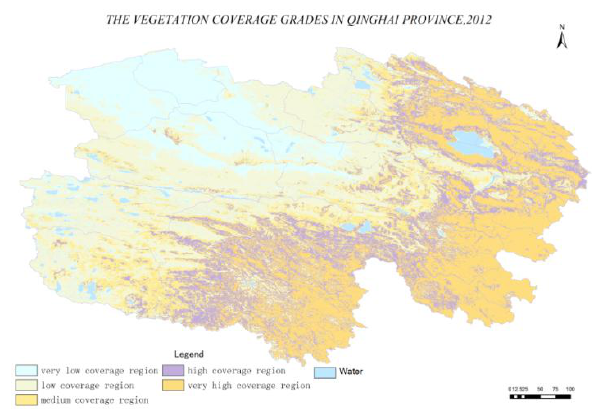
Figure 3. The average of annual maximum vegetation coverage fraction in 2012 in Qinghai province